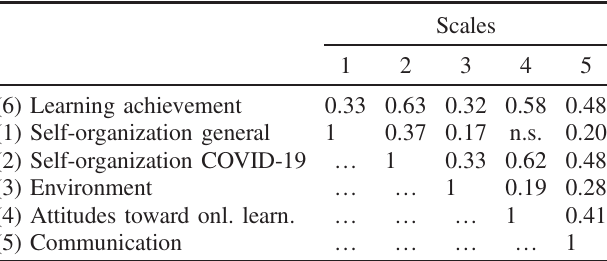
TABLE III. Correlation analysis. Only significant correlations (Pearson ’ s r ; p < 0 . 003 ) are